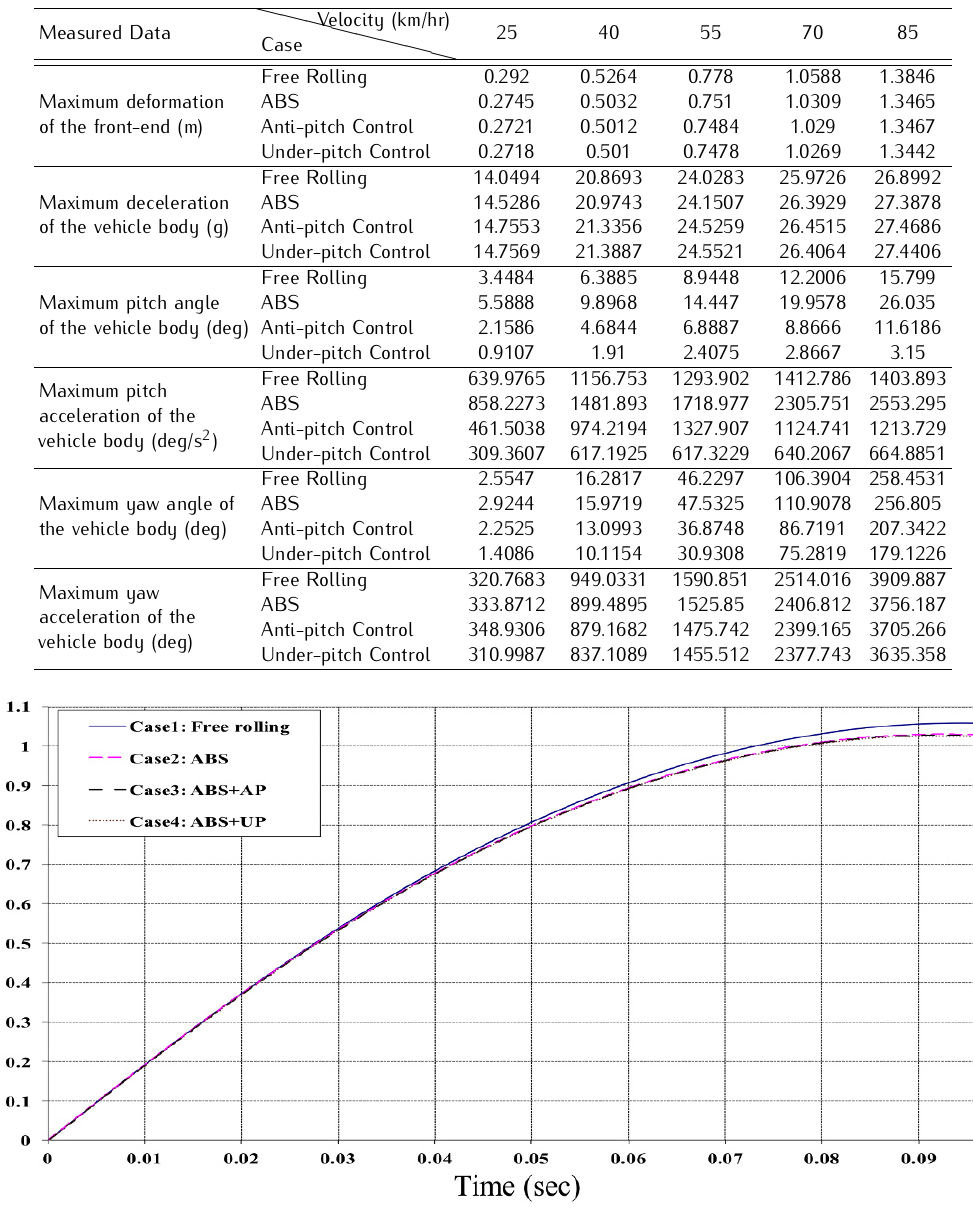
Table 3. Numerical results of an offset frontal crash scenario with different cases of VDCS and different five speeds. Measured Data